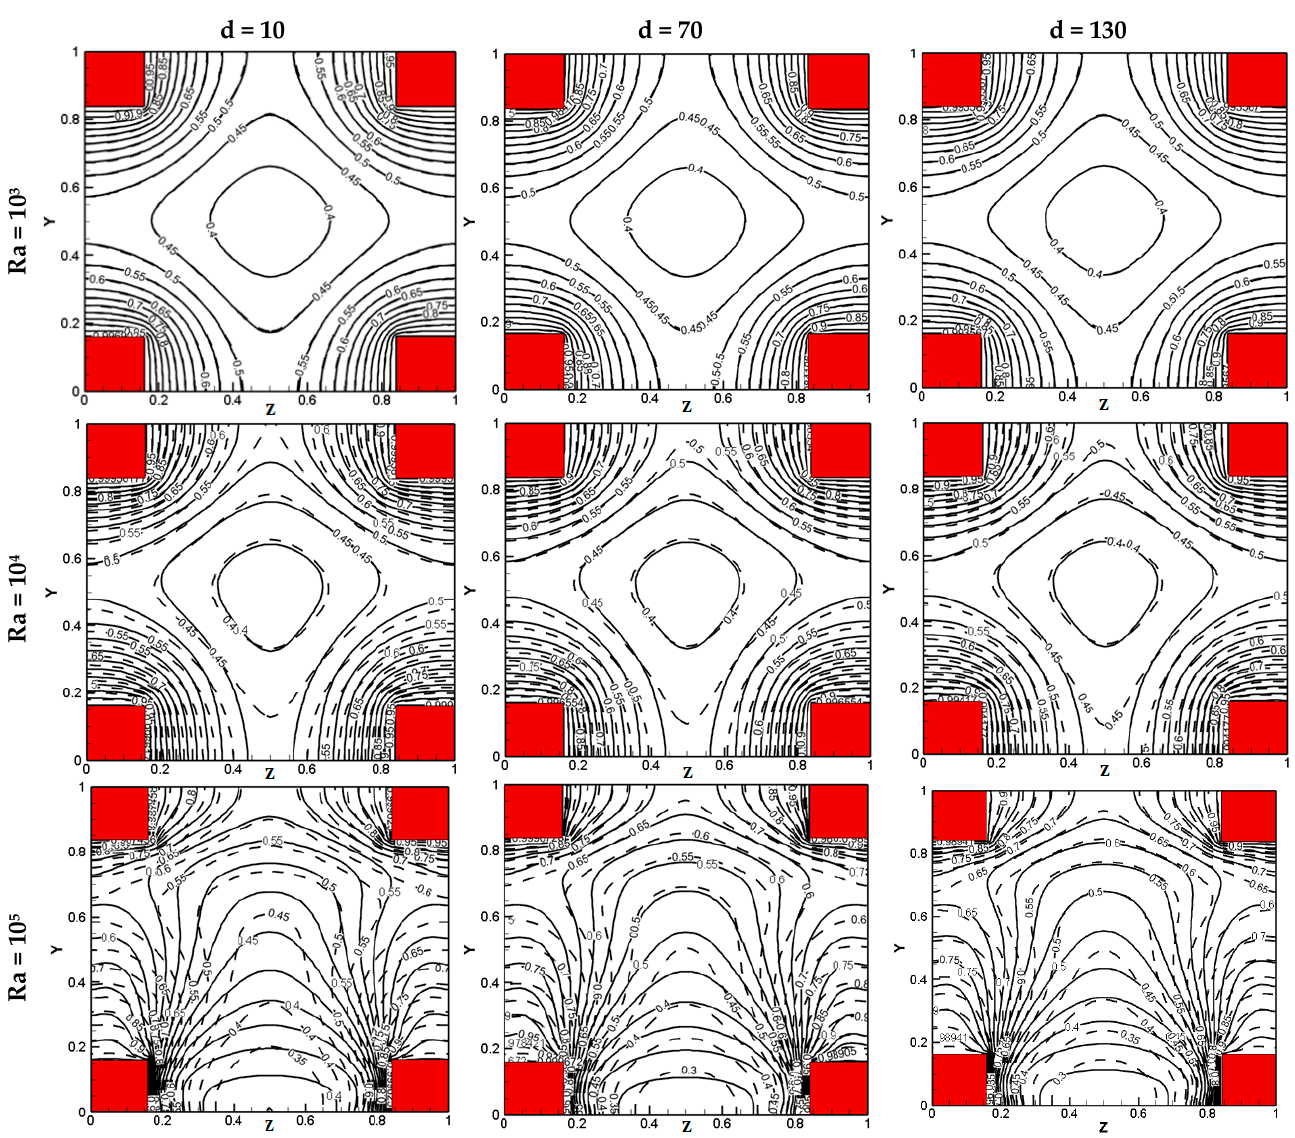
Figure 9. Flow structures inside the cavity for various values of Rayleigh number and diameter of nanoparticle at [ φ = 0 (solid line), φ = 0.04 (dash line)] and Ha = 30. The temperature profiles variation along Y-axis for different values of (Ra) and (d p ) at (Ha = 30 and φ = 0.04) were presented in Figure 10. All these profiles are displayed at (X = Z = 0.5).